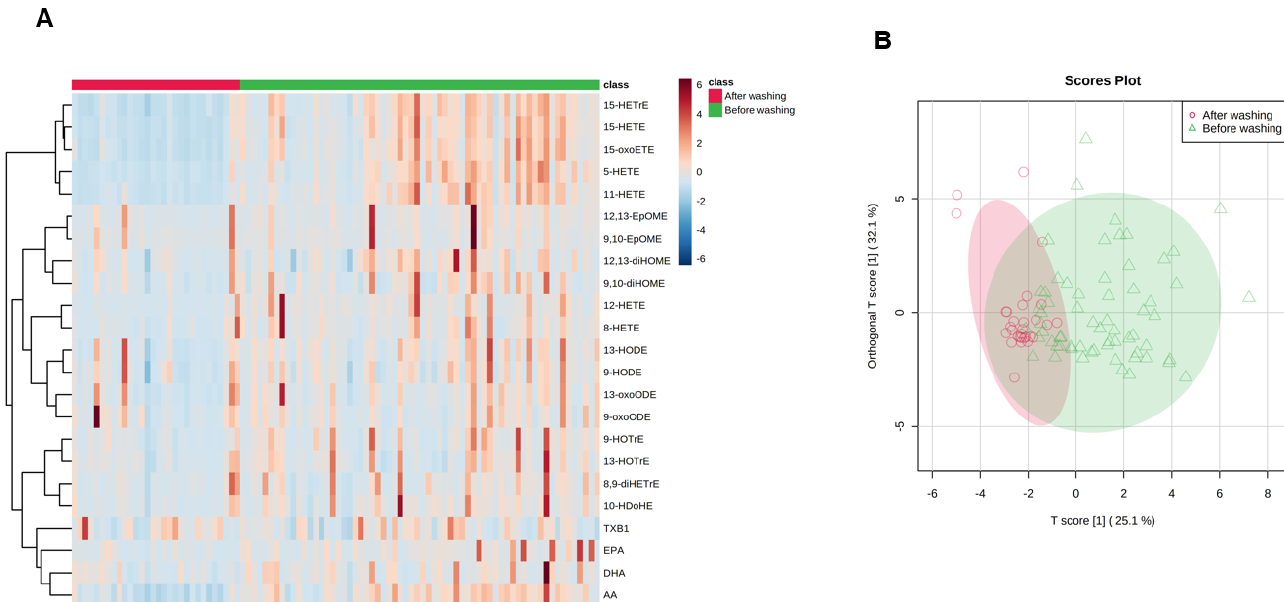
Figure 2. Heat map clustering and orthogonal partial least square discriminant analysis (OPLS-DA) comparing lipid mediator concentrations produced on skin before and after washing. ( A ) Heat map clustering analysis using Ward’s algorithm of skin lipid mediator concentrations that differed significantly between pre- and post-wash conditions, based on one-way ANOVA tests. The color scale from − 6 to 6 represents the z-score, with positive z-score values in red indicating increased lipid mediator concentrations and negative z-score values in blue reflecting decreased lipid mediator concentrations before and after washing. ( B ) OPLS-DA comparing lipid mediator concentrations before and after washing.